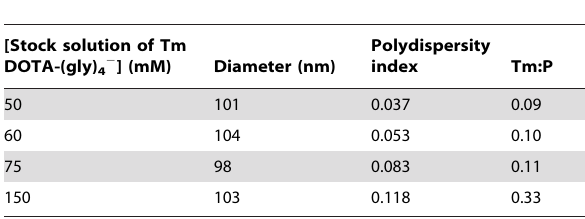
Table 1. Hydrodynamic diameter, polydispersity index and thulium-phosphorus ratio of the liposomes at different concentrations of the encapsulated TmDOTA-(gly) 4 2